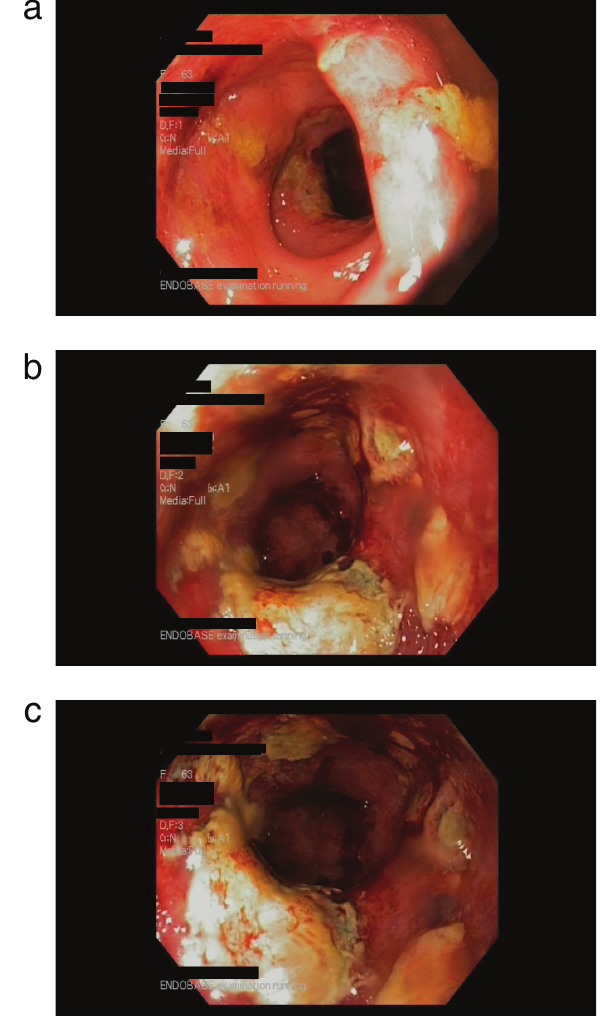
Figure 1A. Rectal endoscopy. Ulceration in the lining of the rectum corresponding to metastases from the ovarian primary.